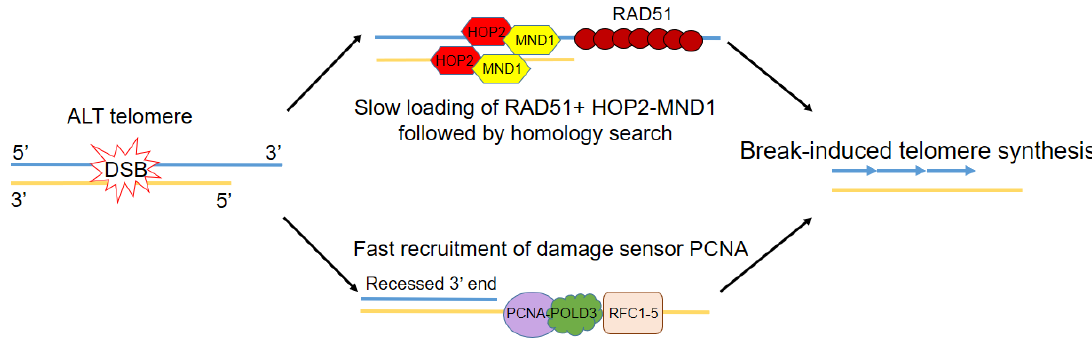
Figure 2. Fast and slow routes to break-induced telomere synthesis. Following double strand break response and end resection at ALT telomeres, two different pathways can be invoked, both leading to break-induced telomere synthesis. One involves the recruitment of RAD51 and HOP2-MND1